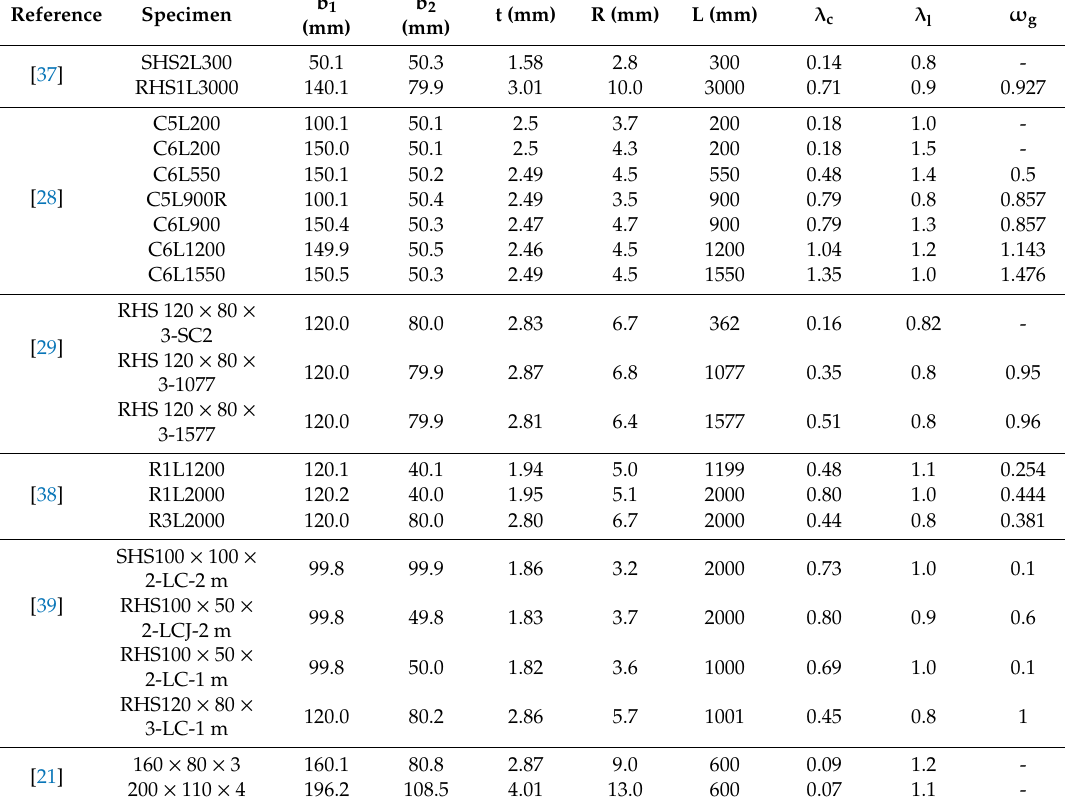
Table 2. Details of the selected stainless steel columns for probabilistic